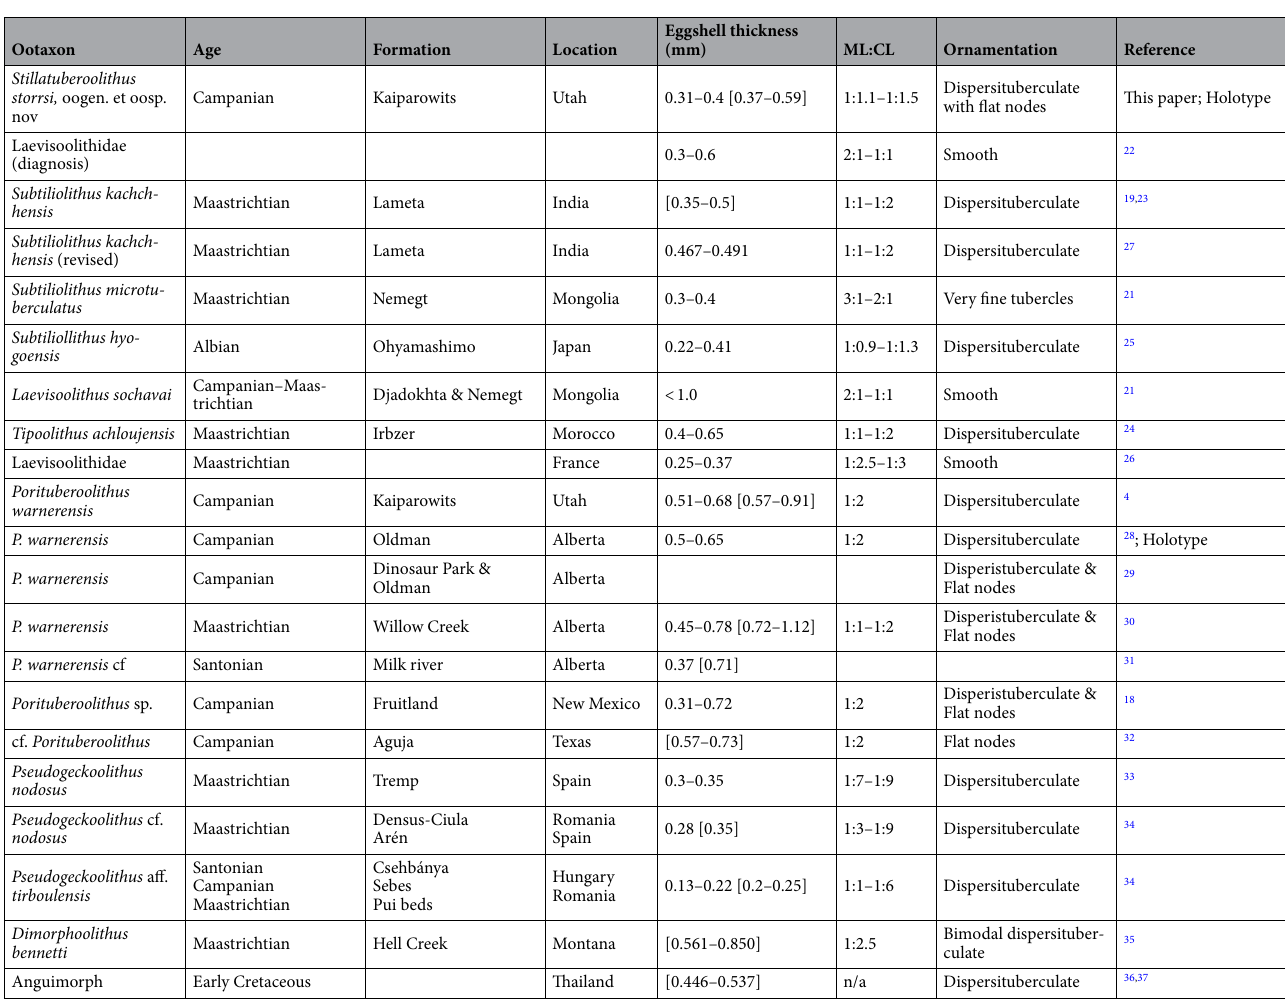
Table 1. Comparison of Stillatuberoolithus storrsi, oogen. et oosp. nov. to similar ootaxa. Brackets indicate eggshell thicknesses including